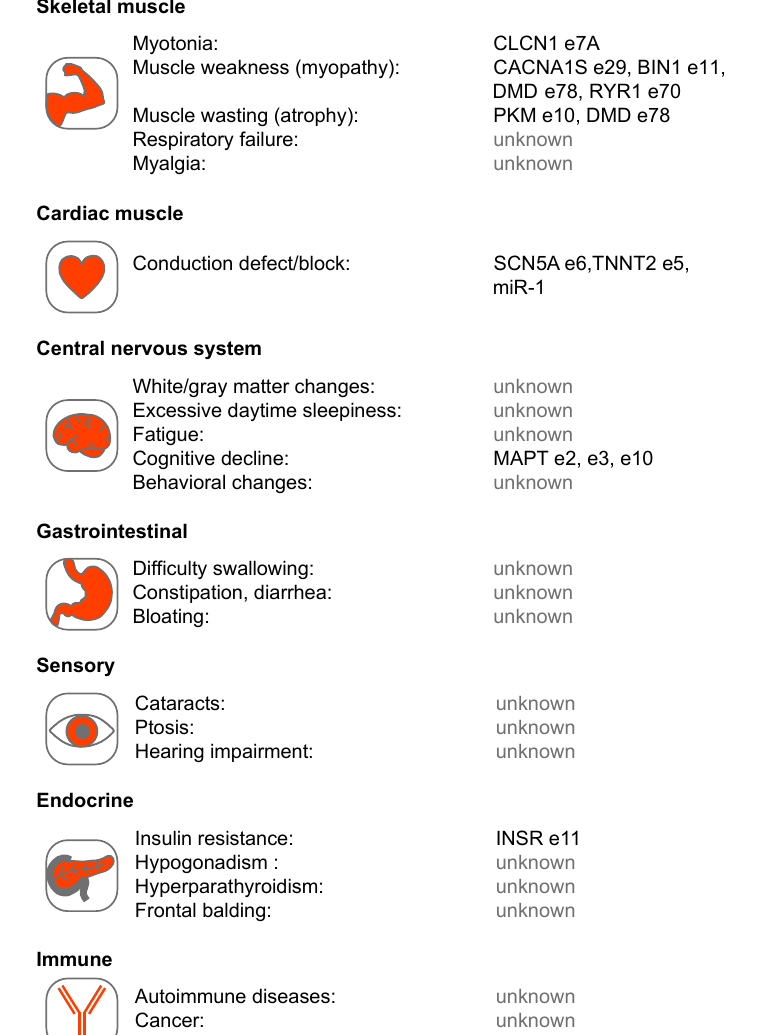
Figure 2. Multi-system involvement in Myotonic Dystrophy types 1 and 2 (DM1 and DM2). Several tissue systems are shown with associated phenotypes together with proposed RNA mis-processing events. These events include: chloride voltage-gated channel 1 (CLCN1) exon (e)7A [81–83], calcium voltage-gated channel subunit alpha1 S (CACNA1S) e29 [84], bridging integrator 1 (BIN1) e11 [85], dystrophin (DMD) e78 [86], ryanodine receptor 1 (RYR1) e70 [87], pyruvate kinase isozymes M1/M2 (PKM1/M2) e10 [88], sodium voltage-gated channel alpha subunit 5 (SCN5A) e6 [89,90], troponin T2, cardiac type (TNNT2) e5 [91], microtubule associated protein tau (MAPT) e2, e3, e10 [92,93], insulin receptor (INSR) e11 [94,95] and microRNA-1 (miR-1) [96].